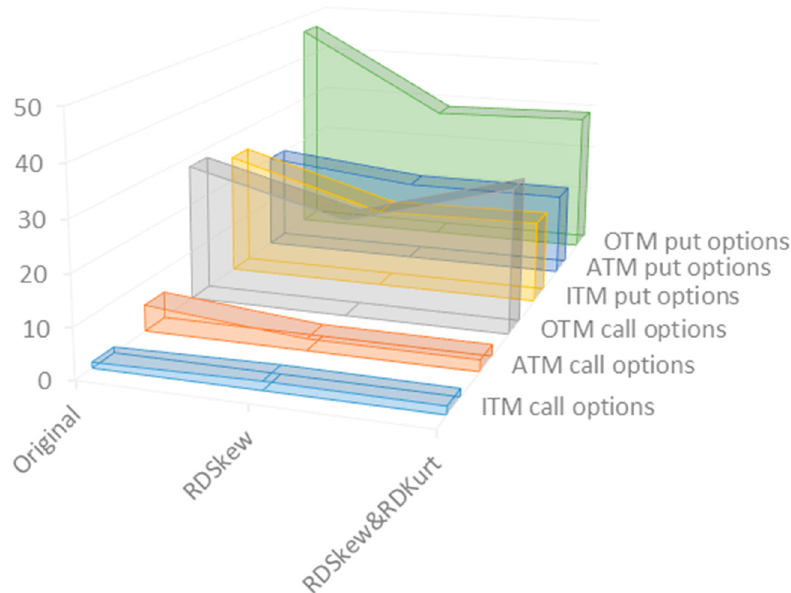
Figure 6. The comparison of the MAPE of different models considering realized skewness and real- ized kurtosis.